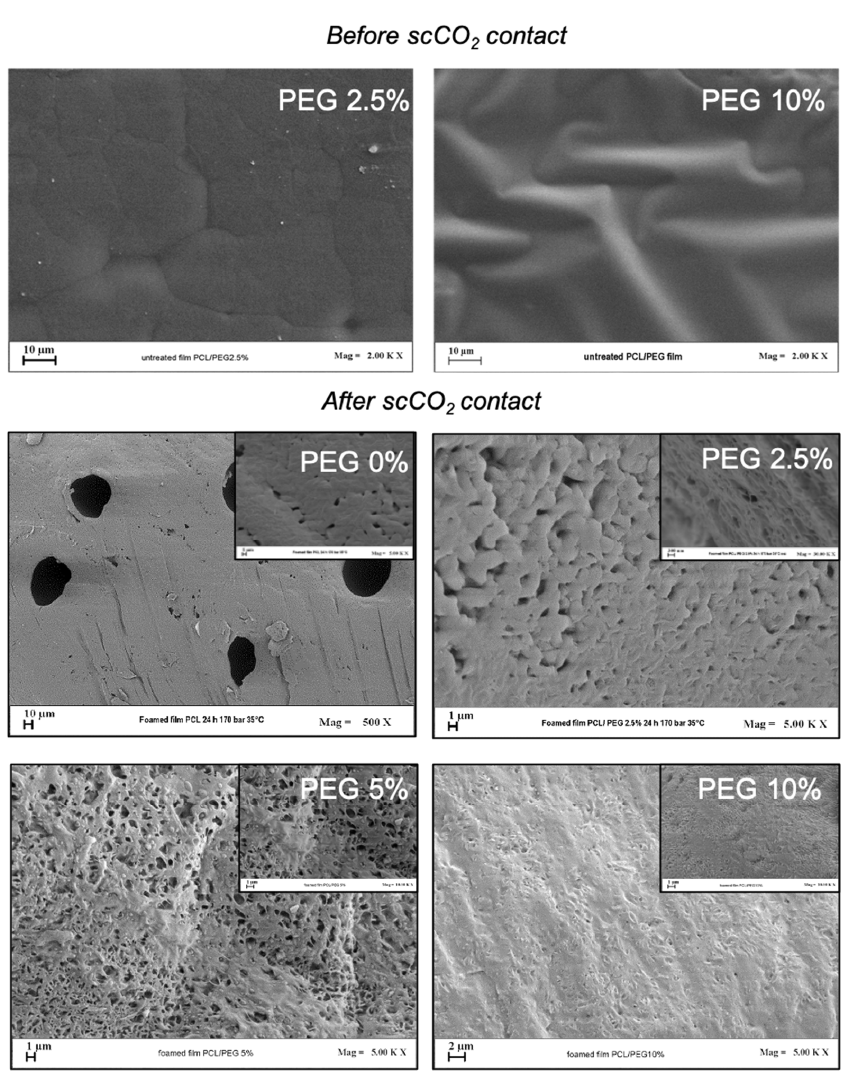
Figure 3. FESEM images of casted film of PCL + PEG2.5% and PCL + PEG10% before the scCO 2 process; and FESEM images after the contact with scCO 2 for 24 h at 170 bar and 35 °C as the PEG percentage varies.